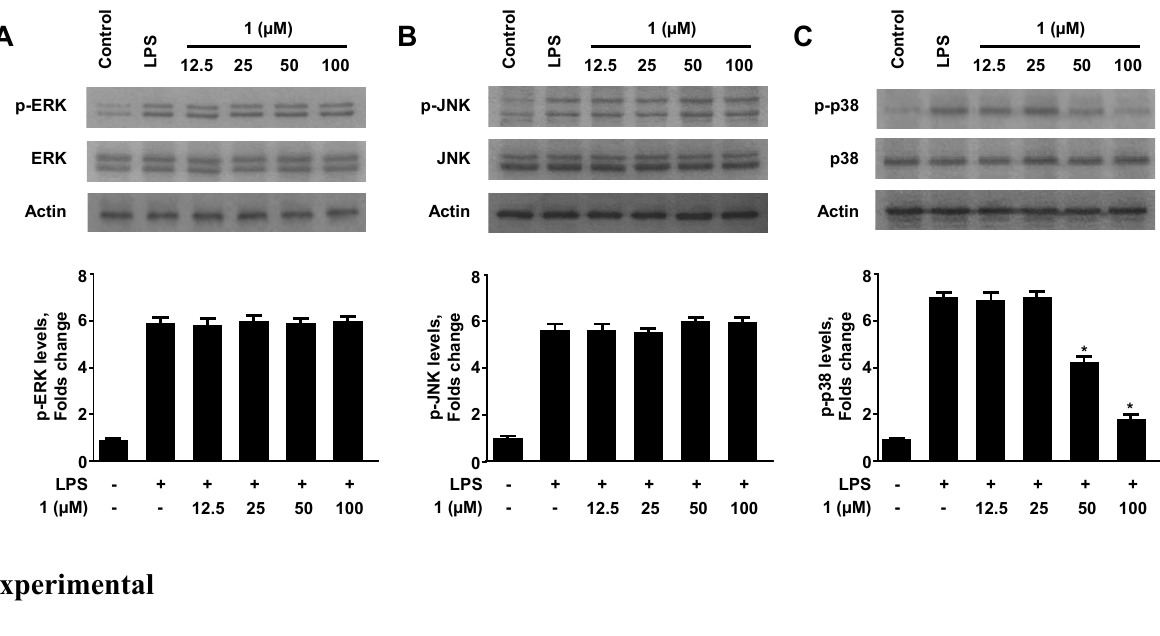
Figure. 6. Effect of neoechinulin A ( 1 ) on ERK, JNK, and p38 MAPK phosphorylation and protein expression. RAW264.7 macrophages were pre-treated for 3 h with the indicated concentrations of neoechinulin A ( 1 ), and stimulated for 30 min with LPS (1 μ g/mL). The levels of (A) phosphorylated-ERK (p-ERK), (B) phosphorylated-JNK (p-JNK), and (C) phosphorylated-p38 MAPK (p-p38 MAPK) were determined by performing Western blotting. Representative blots from three independent experiments with similar results and densitometric evaluations are shown. Data shown represent the mean values of three experiments ± SD. * p < 0.05 as compared to the group treated with LPS